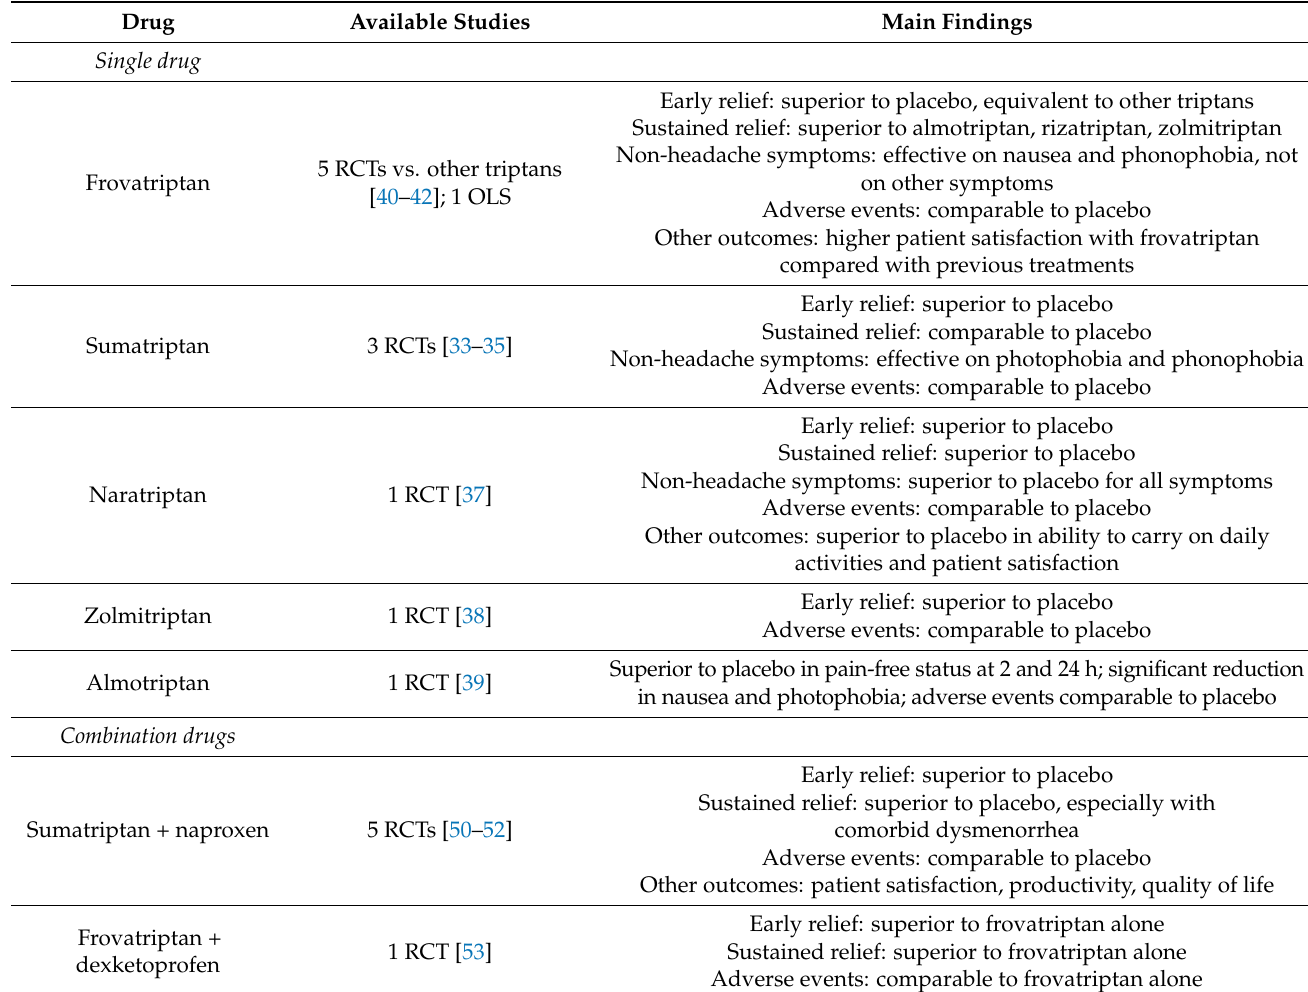
Table 1. Summary of drugs for the acute treatment of menstrual migraine. OLS indicates open-label study; RCT, randomized controlled